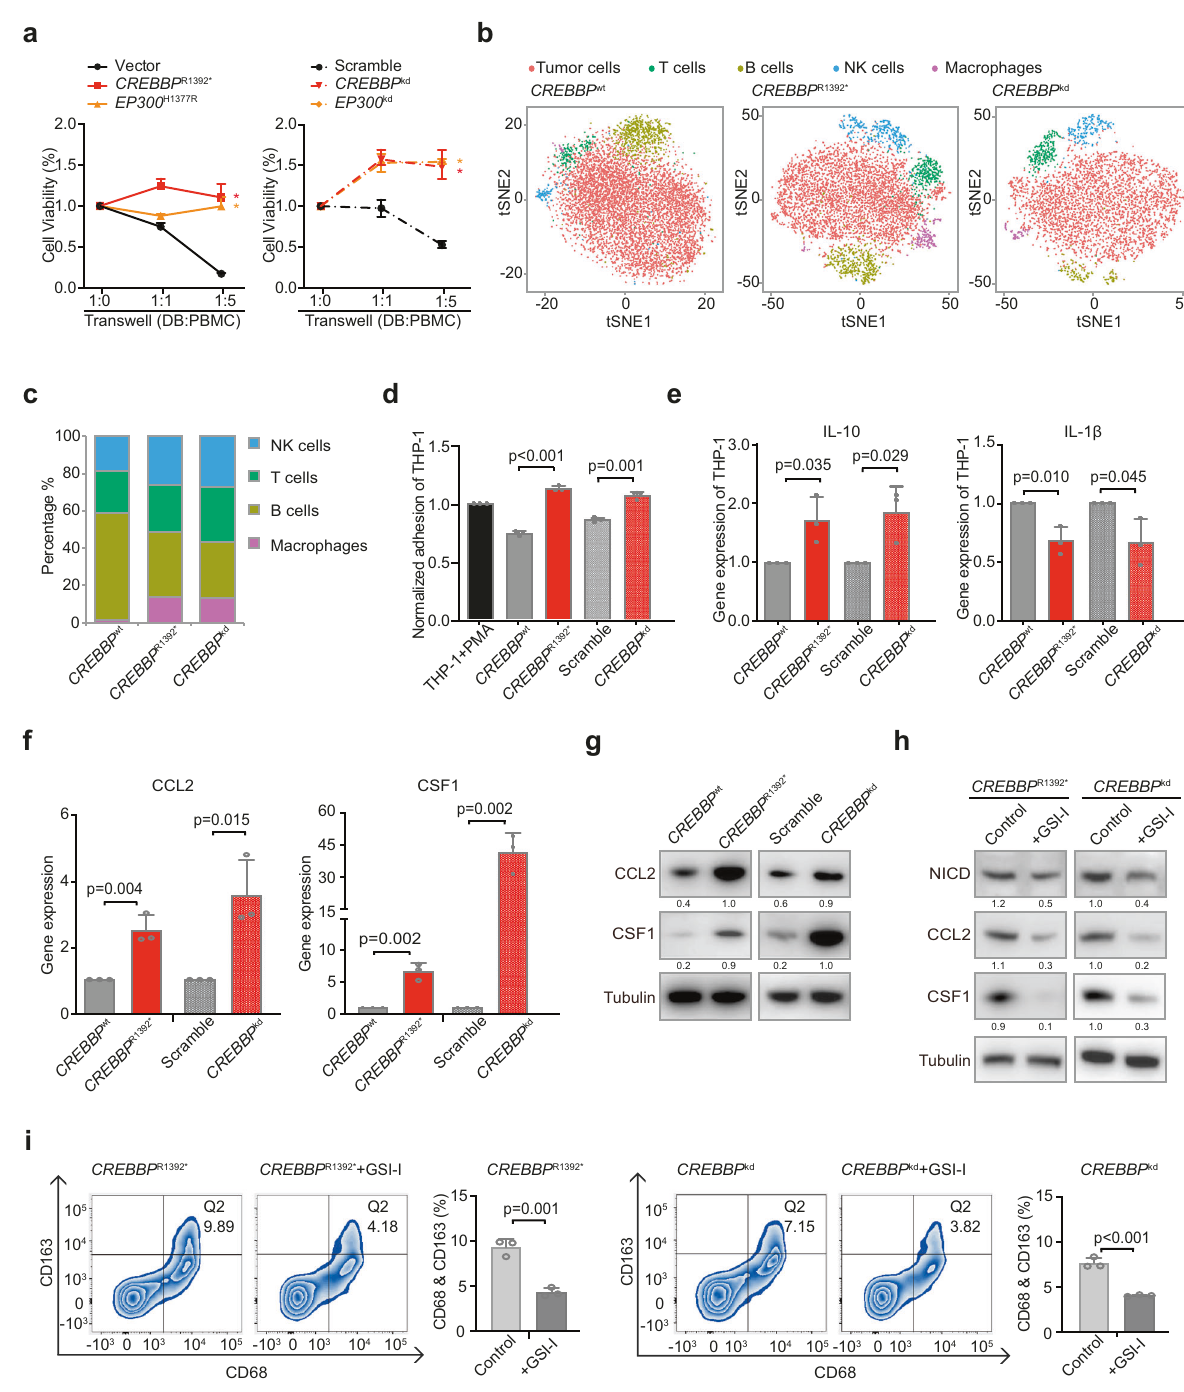
Fig. 6 CREBBP/EP300 mutations promoted macrophage polarization via the FBXW7-NOTCH-CCL2/CSF1 axis in vitro. a The viability of CREBBP R1392* , EP300 H1377R DB cells (left panel), and CREBBP kd , EP300 kd DB cells (right panel) when co-cultured with peripheral blood mononuclear cells (PBMCs) at 1:1 ratio or 1:5 ratio for 72 hours. Data are presented as the mean ± SD ( N = 3). * P < 0.05 comparing with vector or scramble DB cells. b Main sub-clones shown by t-distributed stochastic neighbor embedding (tSNE) mapping of CREBBP wt , CREBBP R1392* , and CREBBP kd DB cells, co-cultured with PBMCs of 1:5 ratio for 72 h. c Fraction of relative proportions of PBMC sub-clones. d THP-1 differentiation assay using tumor-conditioned media from CREBBP wt , CREBBP R1392* , scramble, and CREBBP kd DB cells. Ratios relative to the control (treated with 320 nM phorbol myristate acetate (PMA) for 24 h) are shown. Data are presented as the mean ± SD ( N = 3). e Gene expression of cytokines IL-10 and IL-1 β derived from THP-1 cells cultured by tumor-conditioned media from CREBBP wt , CREBBP R1392* , scramble, and CREBBP kd DB cells by quantitative RT-PCR. Data are presented as the mean ± SD ( N = 3). f CCL2 and CSF1 expression in CREBBP wt , CREBBP R1392* , scramble, and CREBBP kd DB cells by quantitative RT-PCR. Data are presented as the mean ± SD ( N = 3). g Protein expression of CCL2 and CSF1 in CREBBP wt , CREBBP R1392* , scramble, and CREBBP kd DB cells by western blot. h Protein expression of NICD, CCL2, and CSF1 in CREBBP R1392* or CREBBP kd DB cells by western blot with and without γ -secretase inhibitor (GSI-I, 50 μ m) treatment for 48 h. i Flow cytometry analysis of macrophage markers (CD68 and CD163) in PBMCs, co-cultured with CREBBP R1392* or CREBBP kd DB cells with or without GSI-I treatment for 48 h. The results were summed up in the bar graph, presented as the mean ± SD ( N = 3) Signal Transduction and Targeted Therapy (2021)